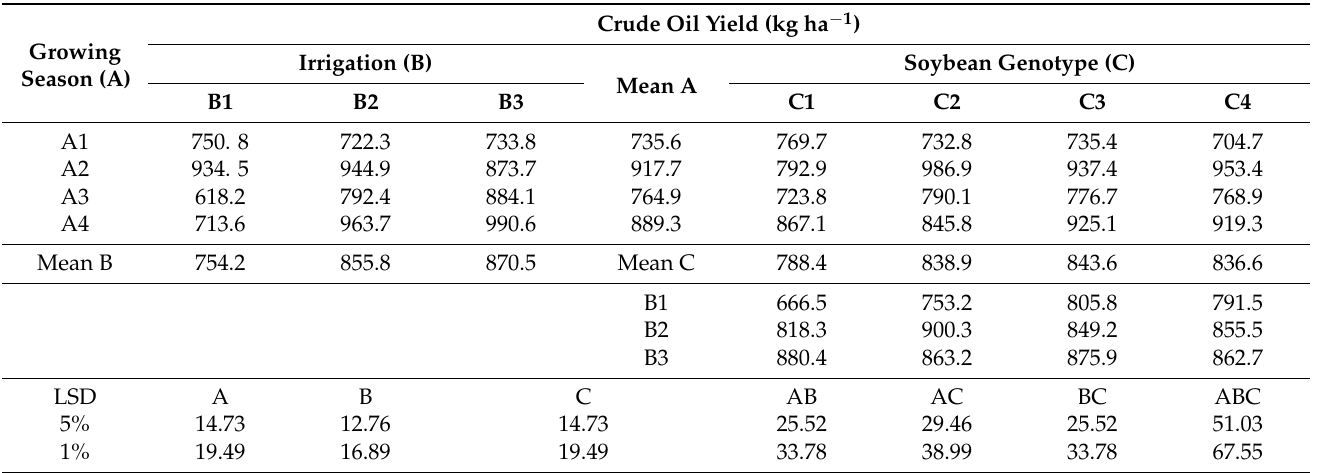
Table 6. Impacts of the environmental conditions in the four growing seasons (A1–A4), three treat- ments (B1, rain-fed conditions; B2, 60% of the field water capacity, or FWC; B3, 80–100% of the FWC), four genotypes (C1–C4) and their interactions (AB, AC, BC and ABC) on crude oil yield (kg ha − 1